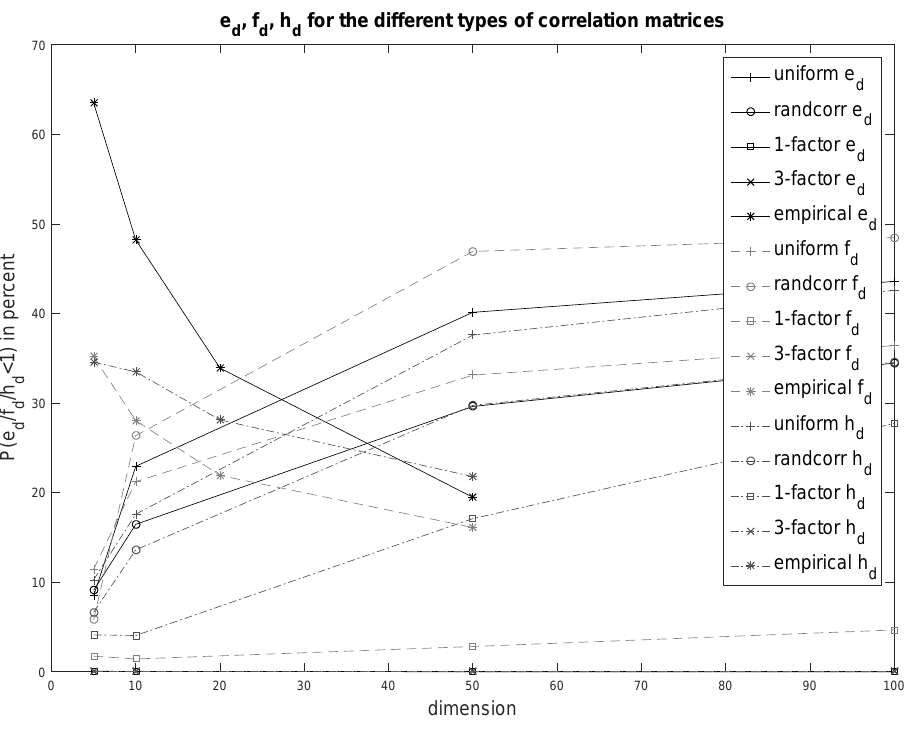
Figure 7: Probability of underweight for different types of correlation matrices: uniform, gallery:randcorr, one-and 3-factor, and